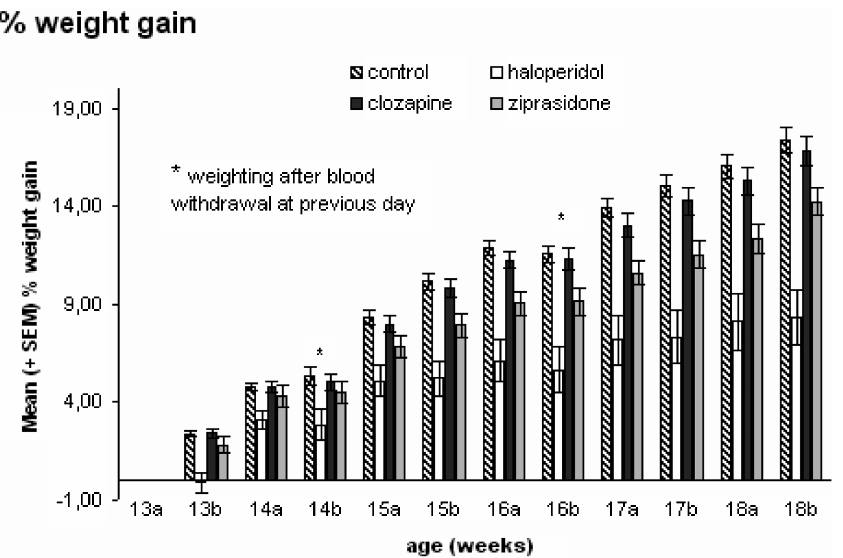
Figure 2 - Percentage weight gain of male Wistar rats: control (n = 19) and animals treated with haloperidol, clozapine, and ziprasidone (n = 20 for all groups). All animals were weighed twice per week. Depicted is the weight after application of the antipsychotic drugs from week 13 to week 18. No difference was found between the control and clozapine groups. The haloperidol- treated animals gained less weight than the control and clozapine group directly after medication, whereas the ziprasidone group gained less weight after 4 weeks of treatment than the control group with p # 0.004 considered